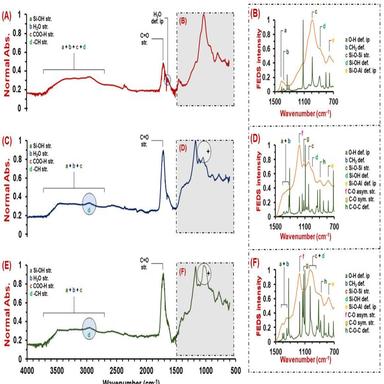
IR-ATR spectra of composites Bent-AA2 (A), Bent-AA-PE1 (C) and Bent-AA-PE6 (E), as well as, corresponding FEDS spectrum (B, D and F, respectively).